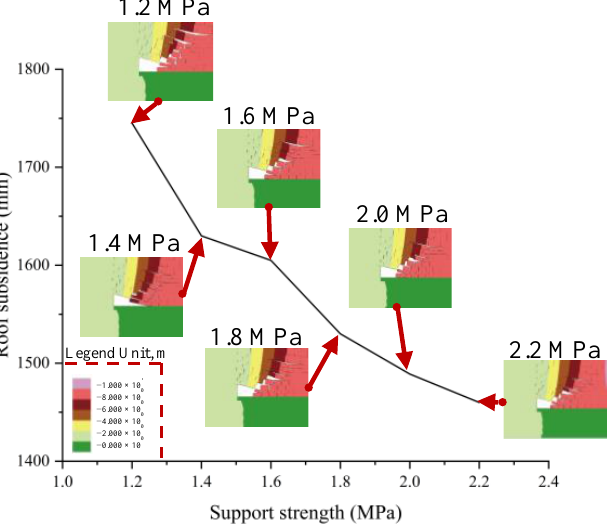
Figure 3. Relationship between support strength and roof subsidence. Table 2. Roof subsidence parameters under different support strength conditions.